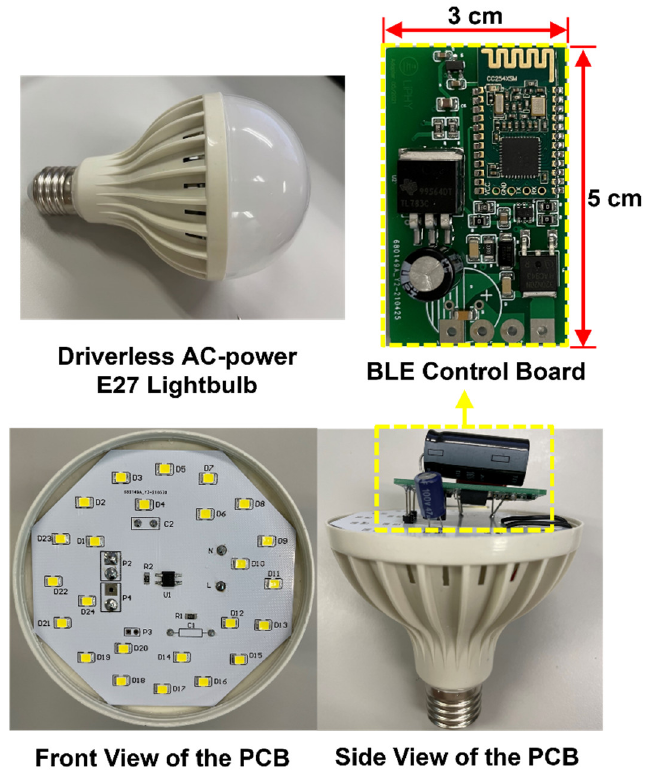
Figure 7. Prototype of VLC LED lightbulb. Table 3. Measured working state of proposed VLC